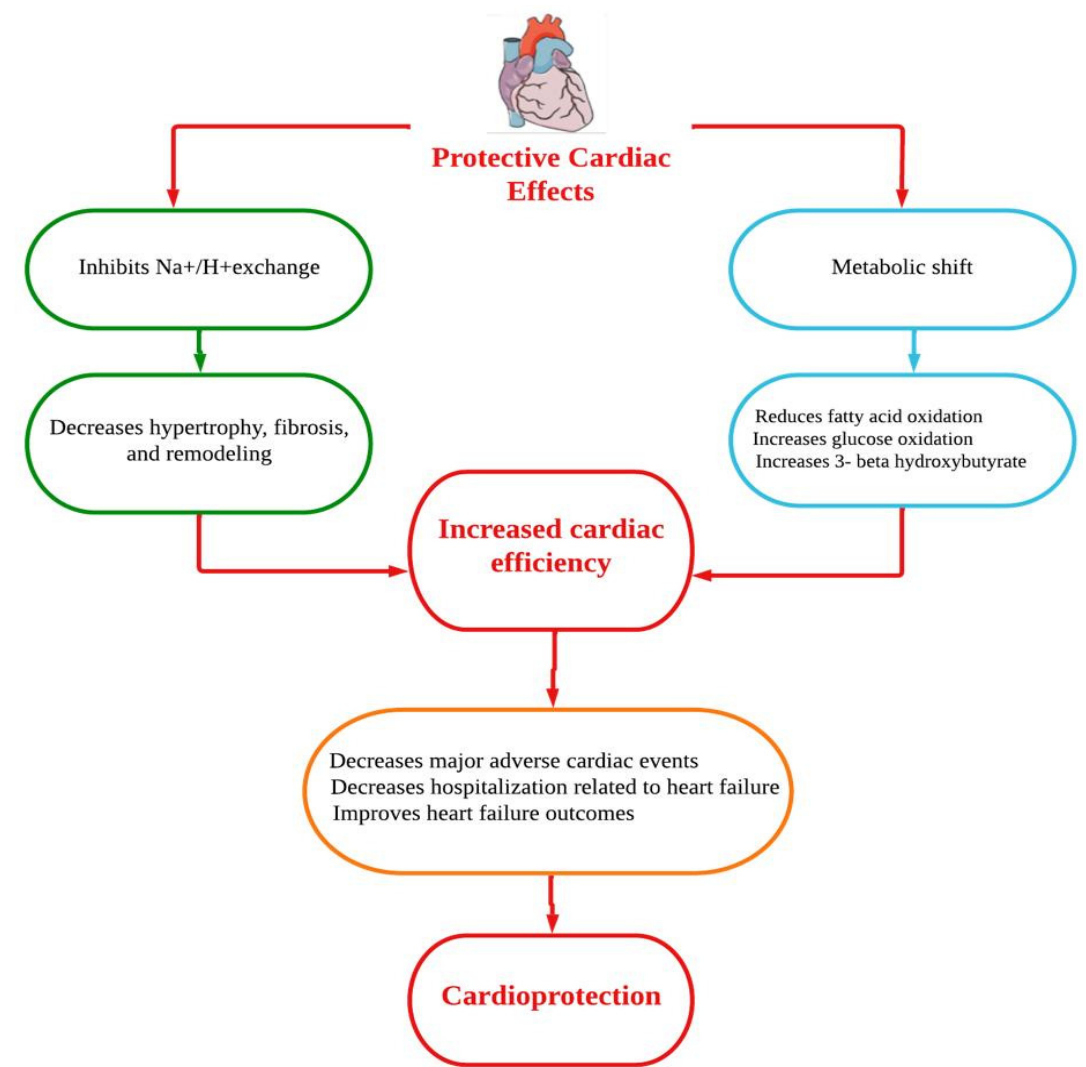
Figure 1. Putative cardioprotective mechanisms of dapagliflozin.